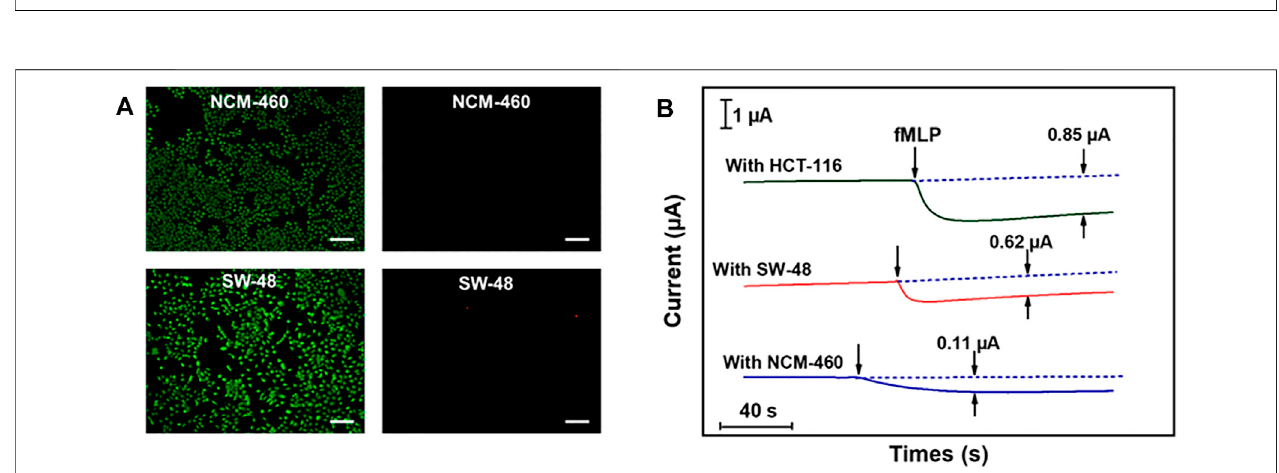
FIGURE 6 | (A) Amperometric current response curves of Cu 2 (OH) 3 NO 3 @ZnO/AGF to 0.2 mM H 2 O 2 , KCl, NaCl, H 2 S, UA, AA, Glu, DA, GSH, DA, U, A, C, and G. Applied potential: − 0.8 V. (B) Current responses of six different Cu 2 (OH) 3 NO 3 @ZnO/AGF to 0.2 mM H 2 O 2 . Inset: Current responses of Cu 2 (OH) 3 NO 3 @ZnO/AGF to 0.2 mM H 2 O 2 for 4 weeks.